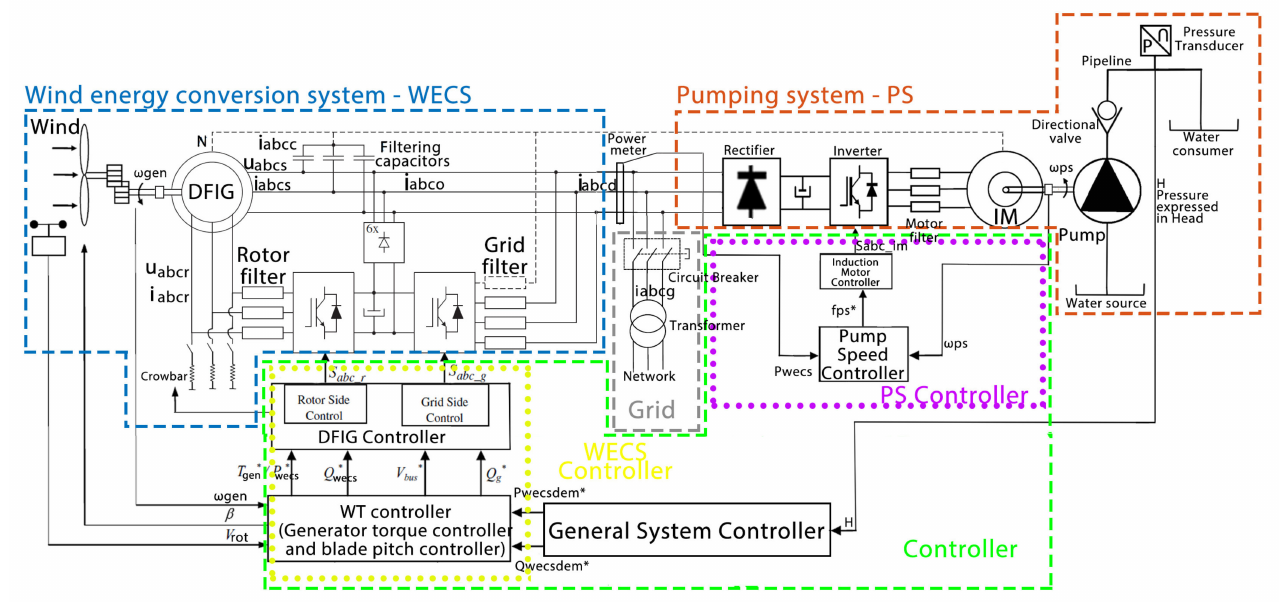
Figure 1. Proposed PS powered by the WECS control